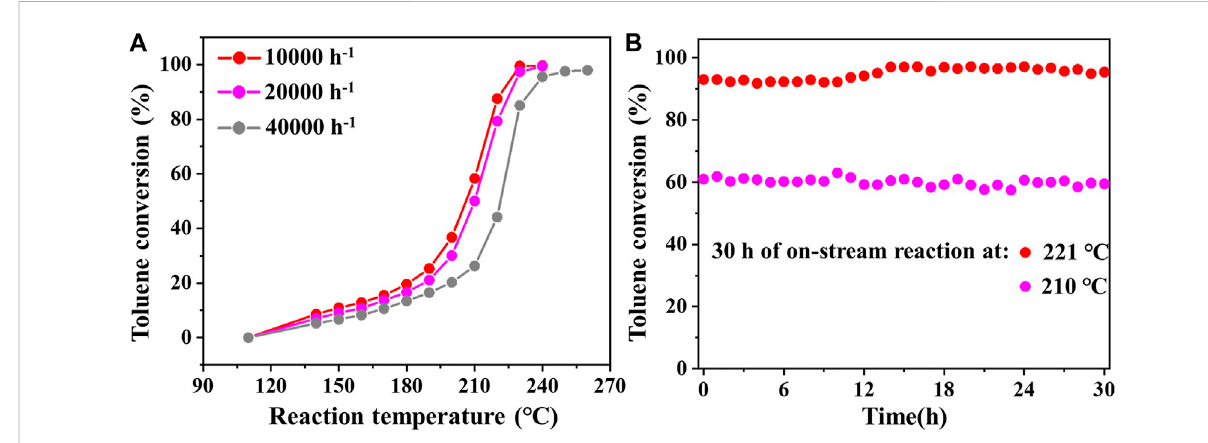
FIGURE 4 (A) Effect of GHSV on the toluene conversion for the 0.05Pd/ δ -MnO 2 -NFA sample; (B) catalytic stability of toluene and o -xylene combustion over 0.05Pd/ δ